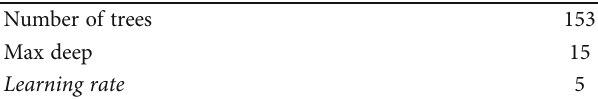
Table 21: Higher precision model for TCGA set: extreme gradient boosting with unbalanced data, hyperparameters. 160 epochs.